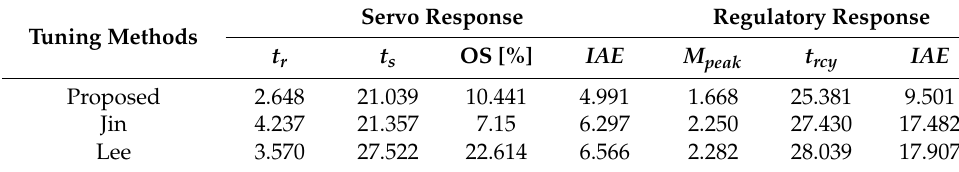
Figure 7. Unit step responses for 20% uncertainty process 𝑃 2 . Table 6. Performance comparisons for 20% uncertainty process P 2